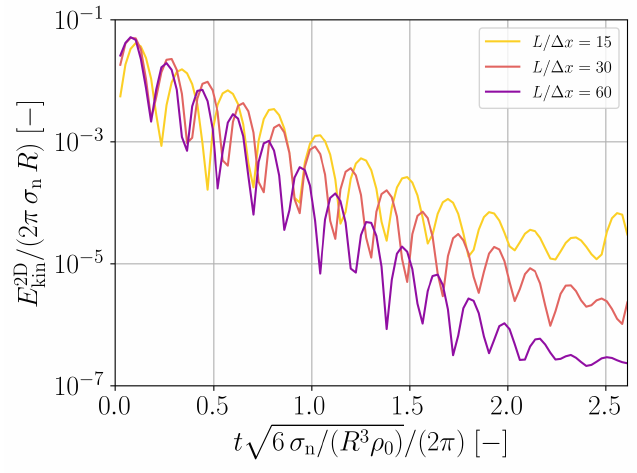
Figure 5. Normalized 2D kinetic energy as a function of normalized time for different spatial resolutions of droplets forming from an initial square patch.